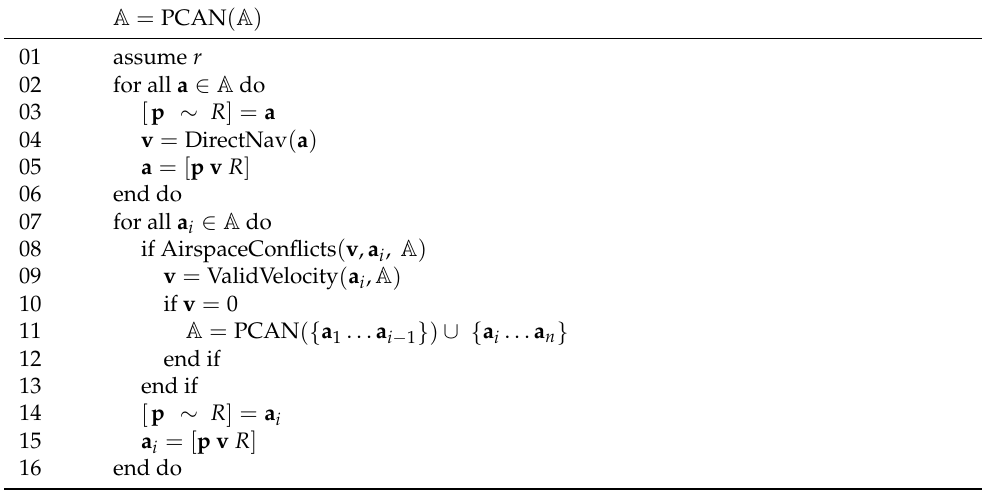
Table 6. The PCAN